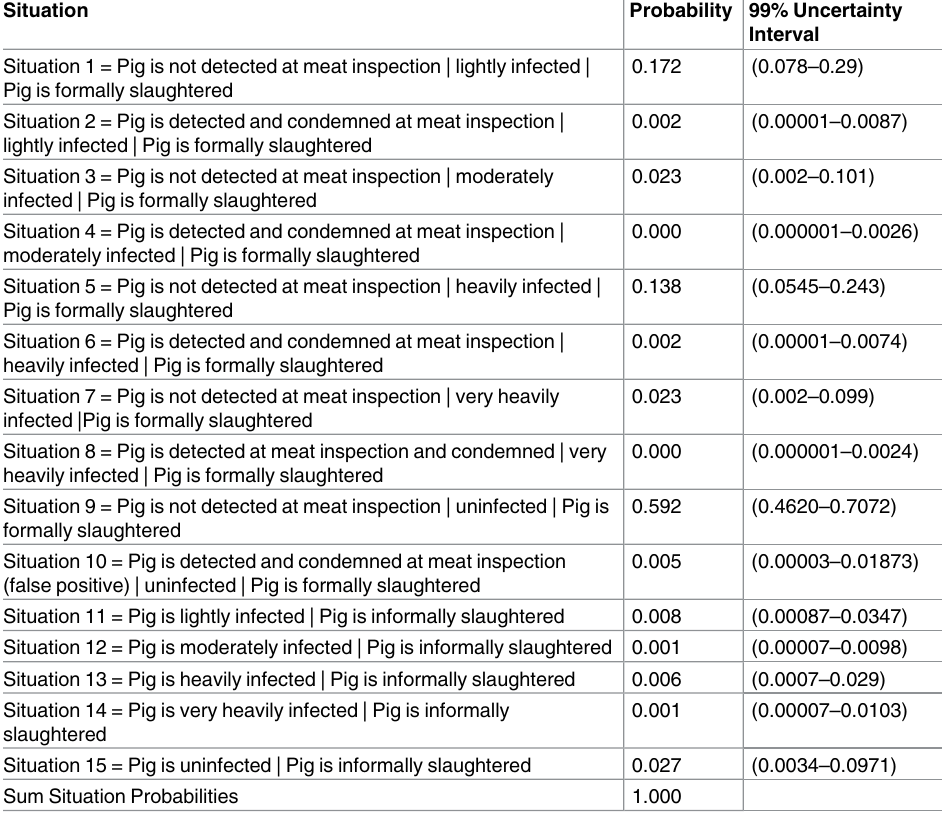
Interval 0.172 (0.078–0.29) 0.002 (0.00001–0.0087) 0.023